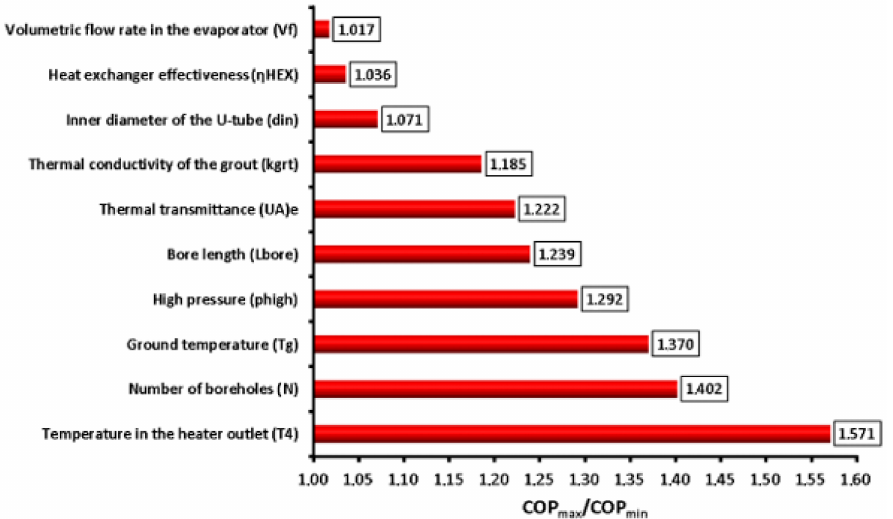
Figure 24. Ranking of the parameters according to the influence on the COP in the examined